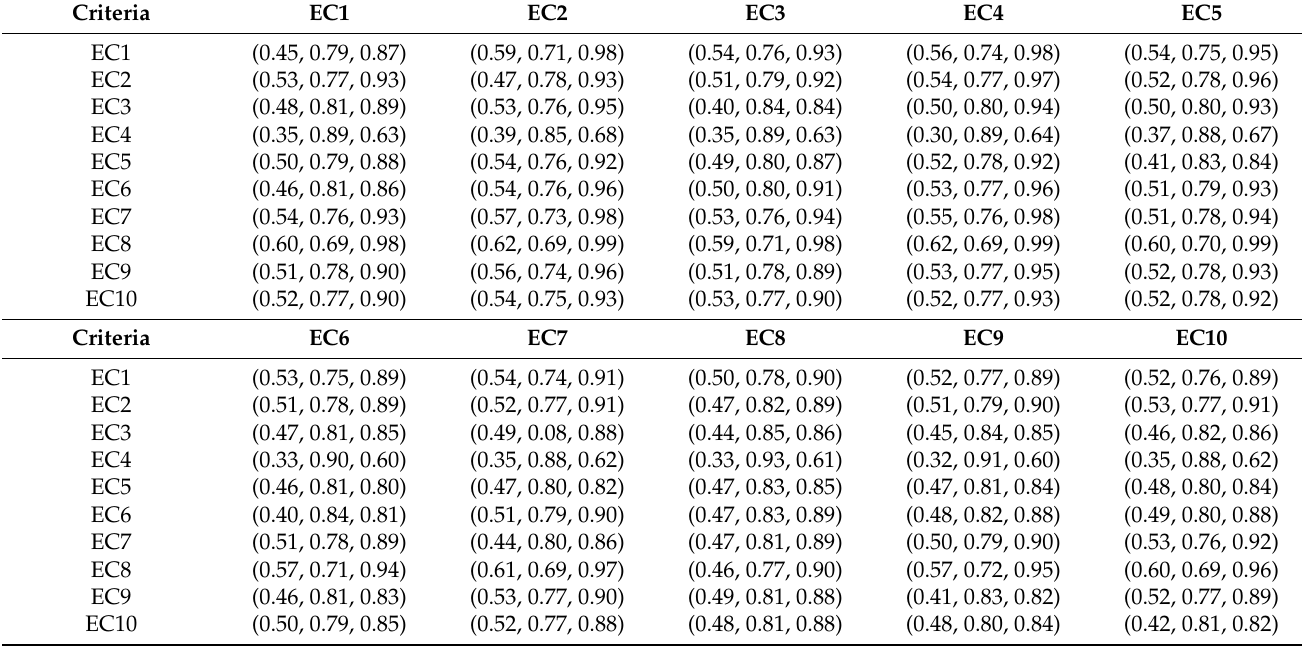
Table 7. Spherical fuzzy total influence